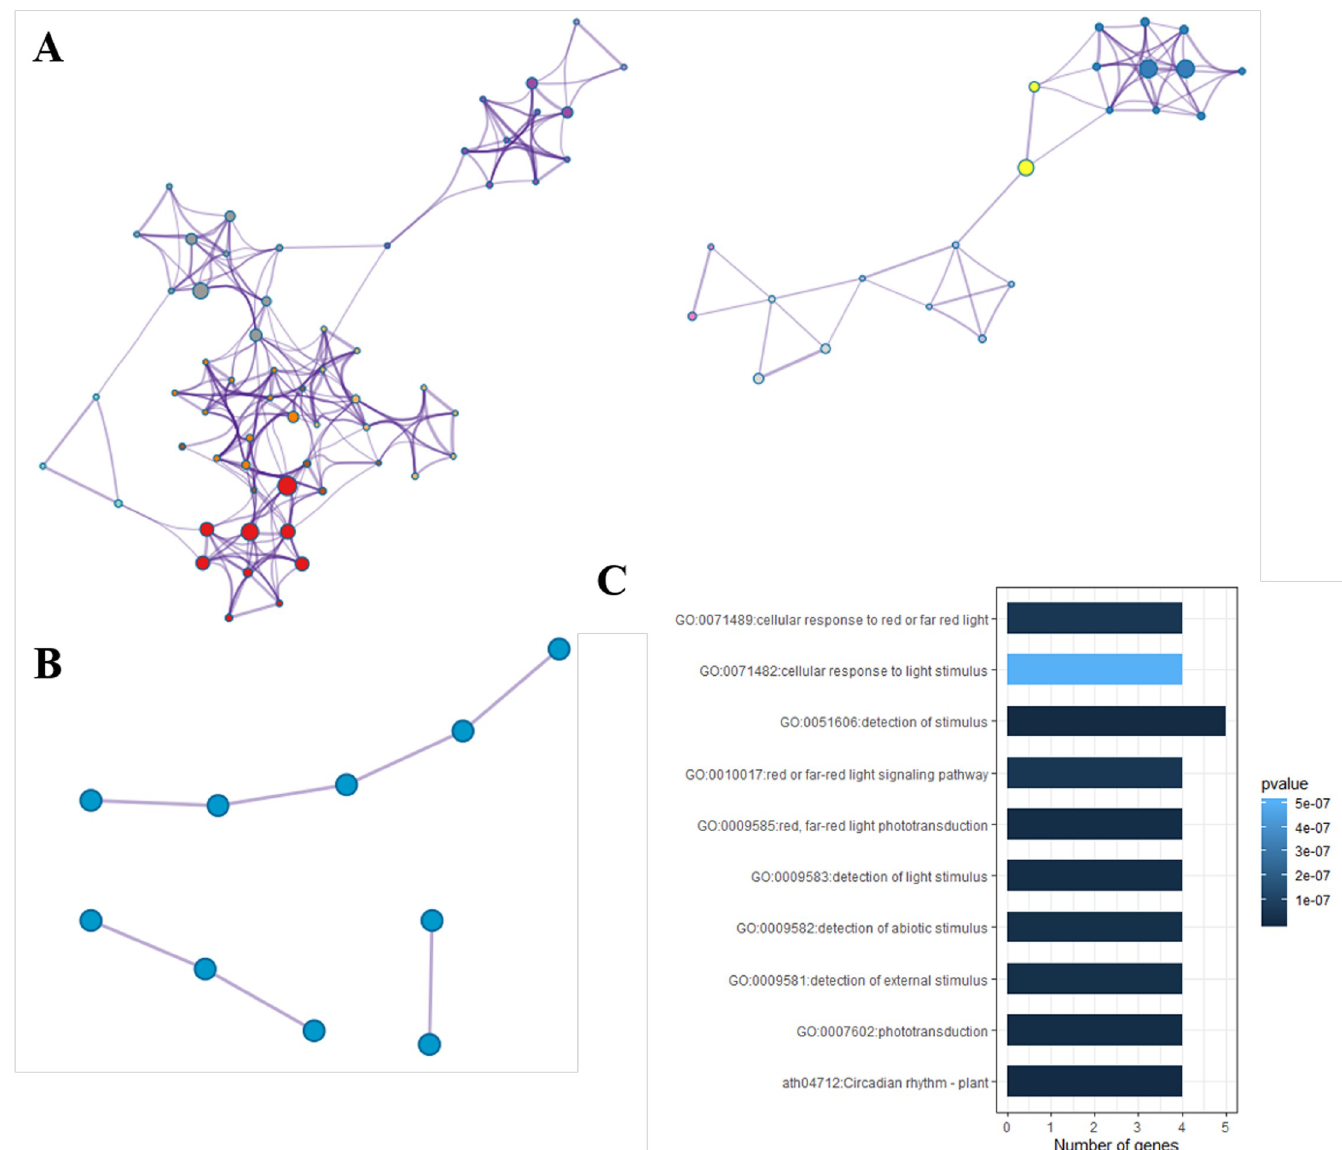
Fig 4. Metascape analysis of co-DEGs. (A) Network of enriched terms: colored by cluster ID, Threshold: 0.3 kappa score; similarity score > 0.3. (B) Module analysis: the three best-scoring terms by p-value. (C) Pathway and process enrichment in the three best-scoring terms. Heatmap colored by P-values.